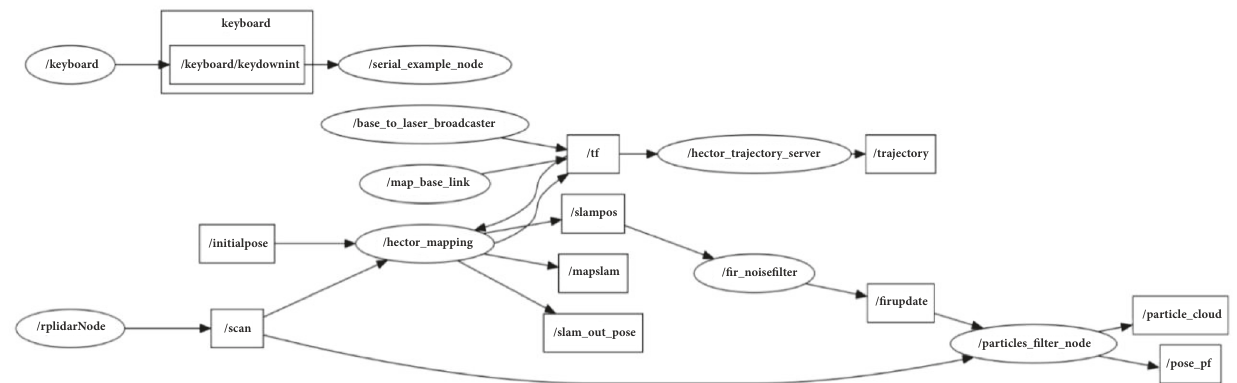
Figure 4: Diagram of all implemented ROS